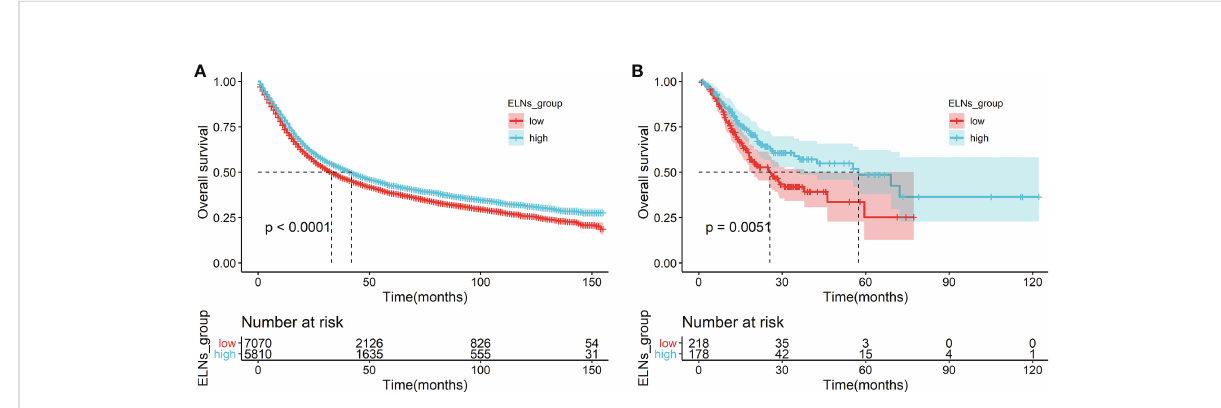
FIGURE 3 Survival analyses of OS in the ELNs group. (A) OS for high (>16) and low ( ≤ 16) ELNs in the training cohort. (B) OS for high (>16) and low ( ≤ 16) ELNs in the external validation cohort (The Cancer Genome Atlas). ELNs, the number of examined lymph nodes; OS, overall